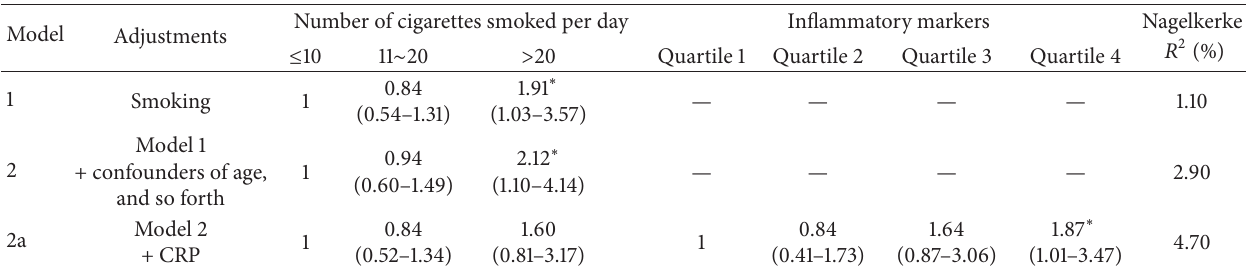
Table 4: The association between number of cigarettes smoked per day and type 2 diabetes and the mediation by CRP in 984 Chinese current smokers (OR; 95% CI) #